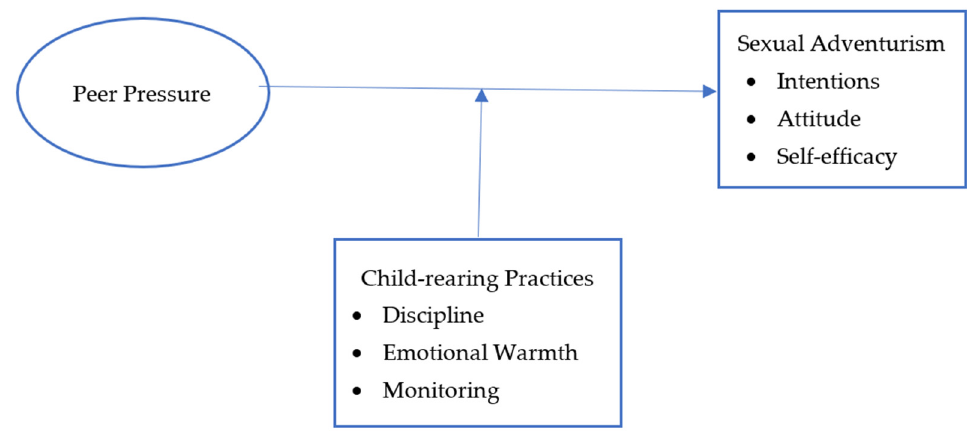
Figure 1. Conceptual framework showing the moderating role of child-rearing practices in the link between peer pressure and sexual adventurism.